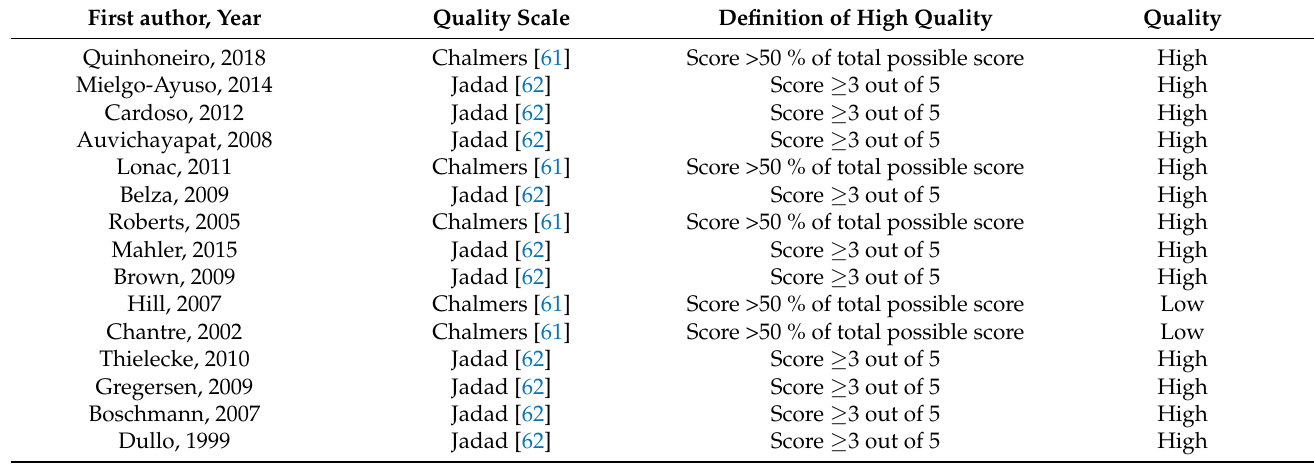
Table 4. Sensitivity